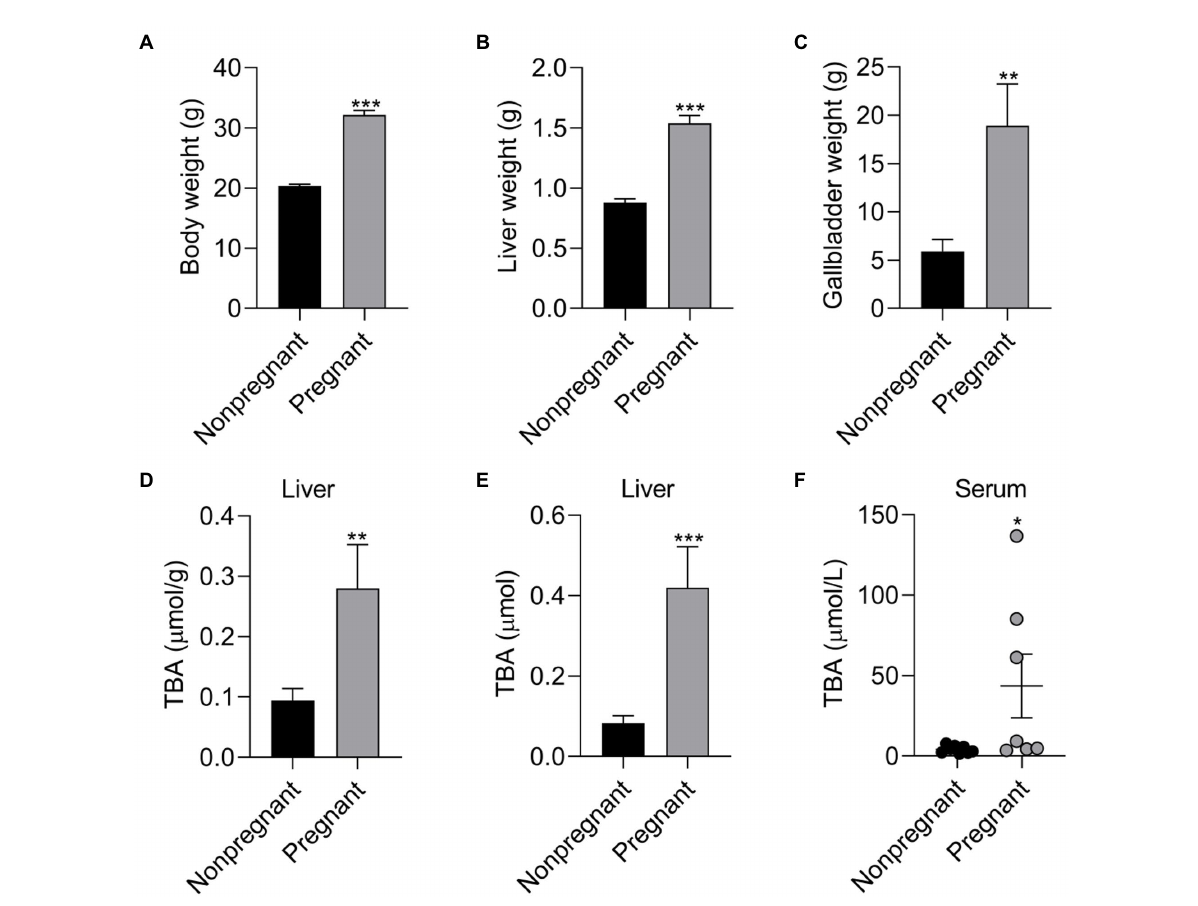
FIGURE 6 The effect of pregnancy on the body composition and BA level of female mice. The effect of pregnancy on (A) body weight, (B) liver weight and (C) gallbladder weight of female mice; The effect of pregnancy on (D) TBA concentration, (E) TBA levels of liver, and (F) serum TBA levels of female mice. Data are shown as means ± SE, * p < 0.05, ** p < 0.01, *** p <